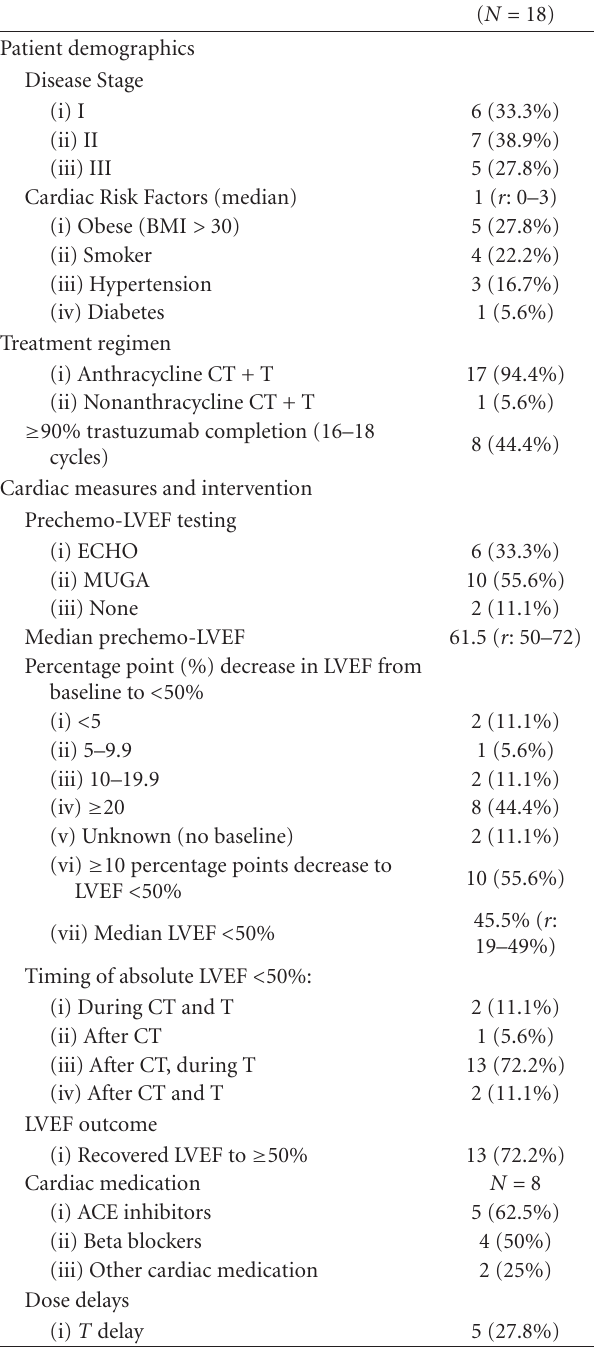
Table 5: Patients with at least one absolute LVEF <